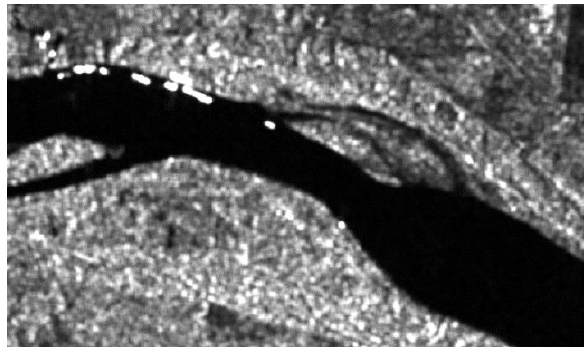
Figure 16. Vessel situation (3) - Zimnicea – 09.08.2015 -